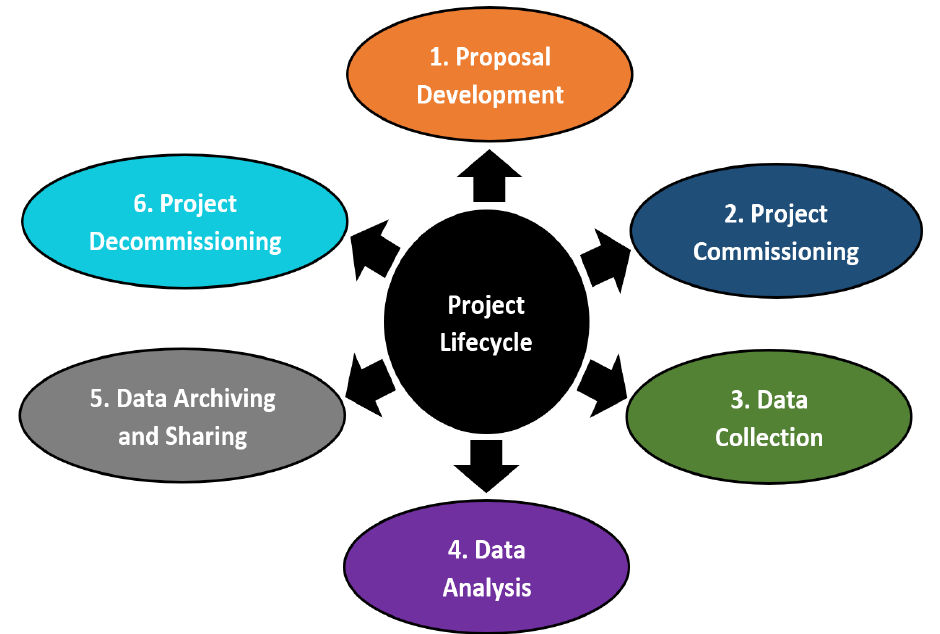
Figure 1. Project life